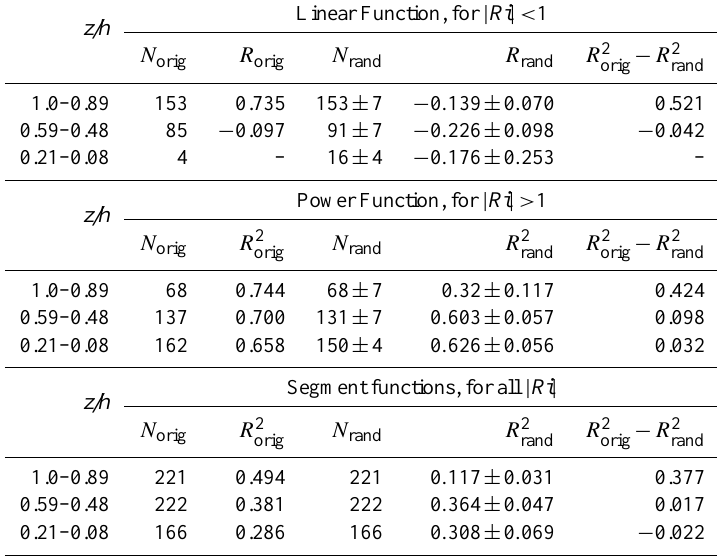
Table 3. Self-correlation analysis between the local flux-profile relationship of wind speed, φ m , and local bulk Richardson number, Ri , in forest canopy, for a linear relation with | Ri | < 1, a power function with | Ri | > 1, and these segment functions for the entire data set. Linear Function, for | Ri | < 1 z/h N orig R